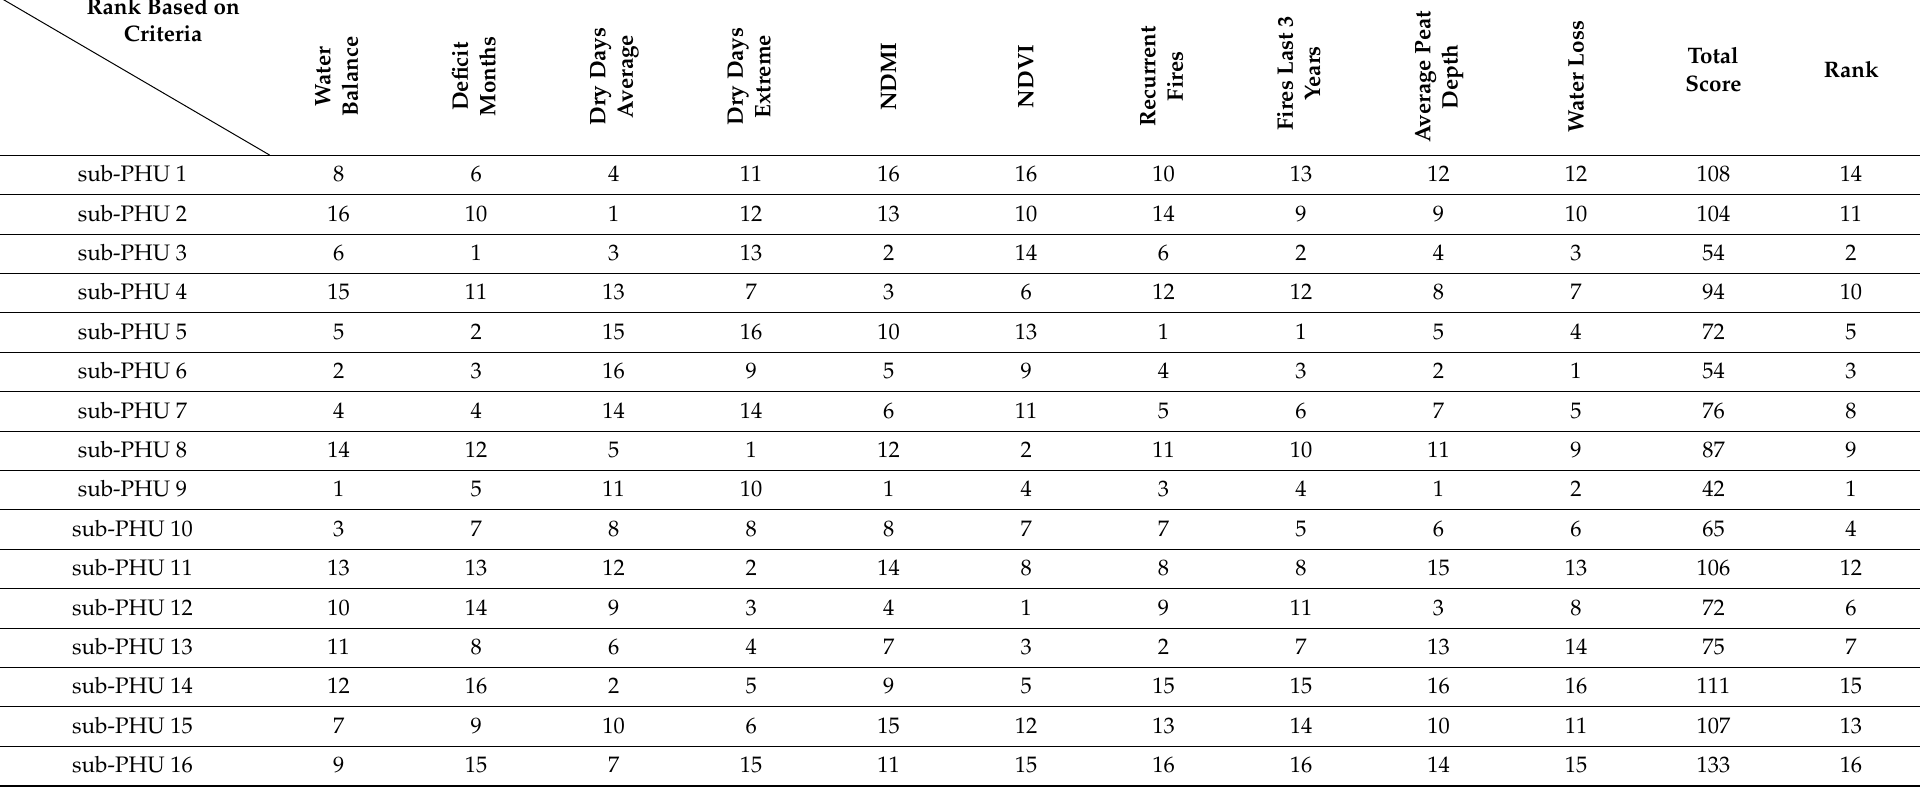
Table 8. The rank of sub-PHUs based on 11 criteria to determine the most prioritized areas in the Kahayan–Sebangau PHU. Rank Based